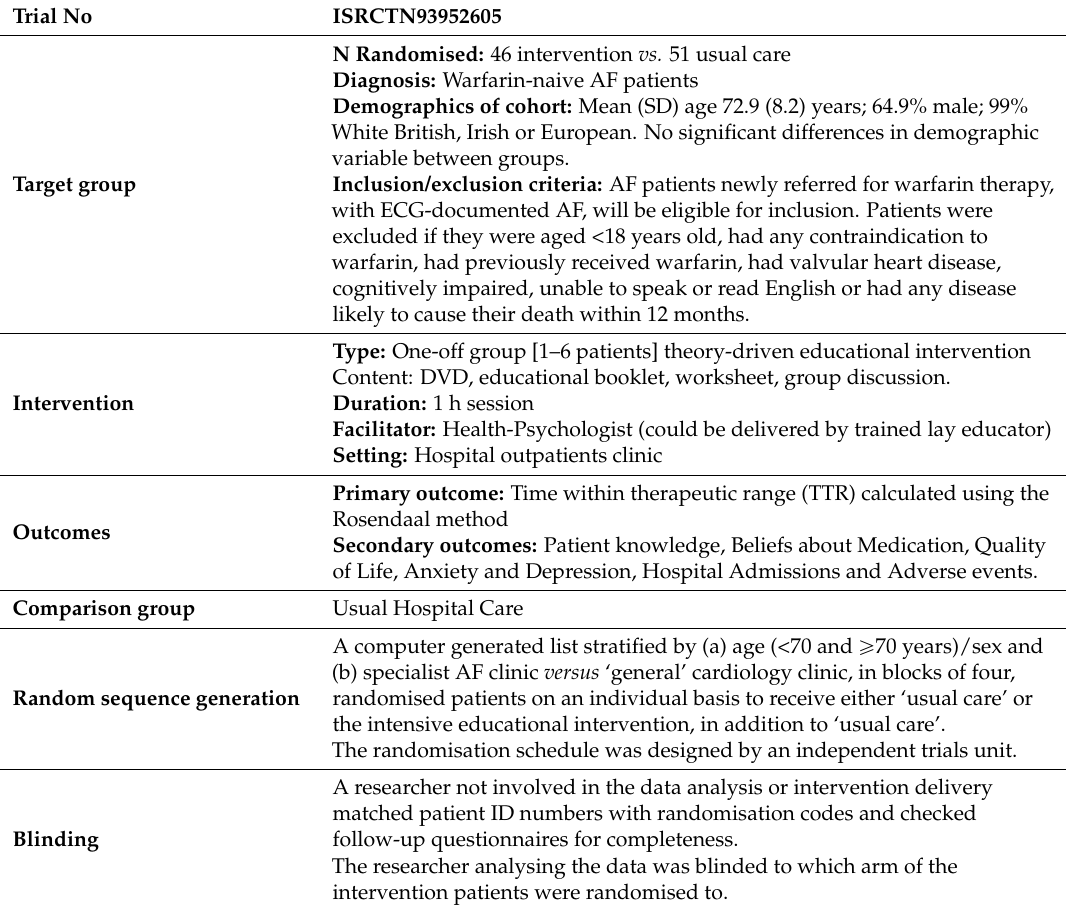
Table 4. Summary of the TREAT randomised controlled